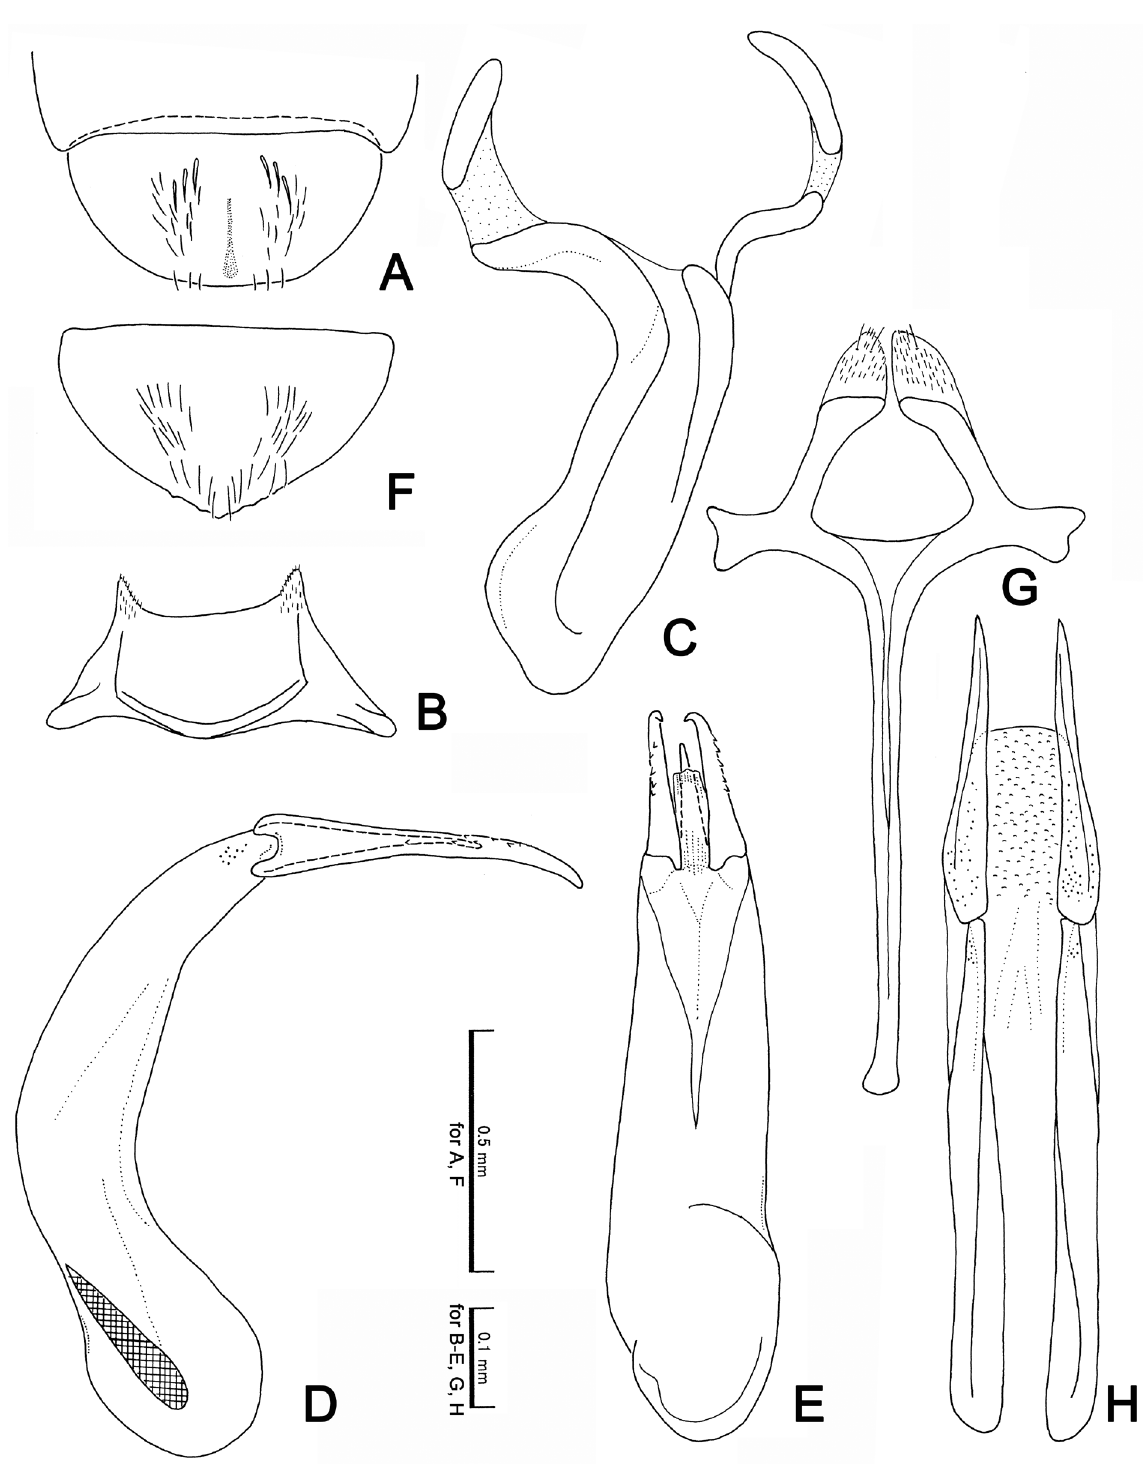
Fig. 6. Acontosceles borneensis sp. nov., male (A–E) and female (F–H) genitalia (holotype and paratype, BPBM). A, F . Sternite VII. B . Sternite VIII. C . Sternite IX. D . Aedeagus, left lateral view. E . Aedeagus, ventral view. G . Urosternite. H .